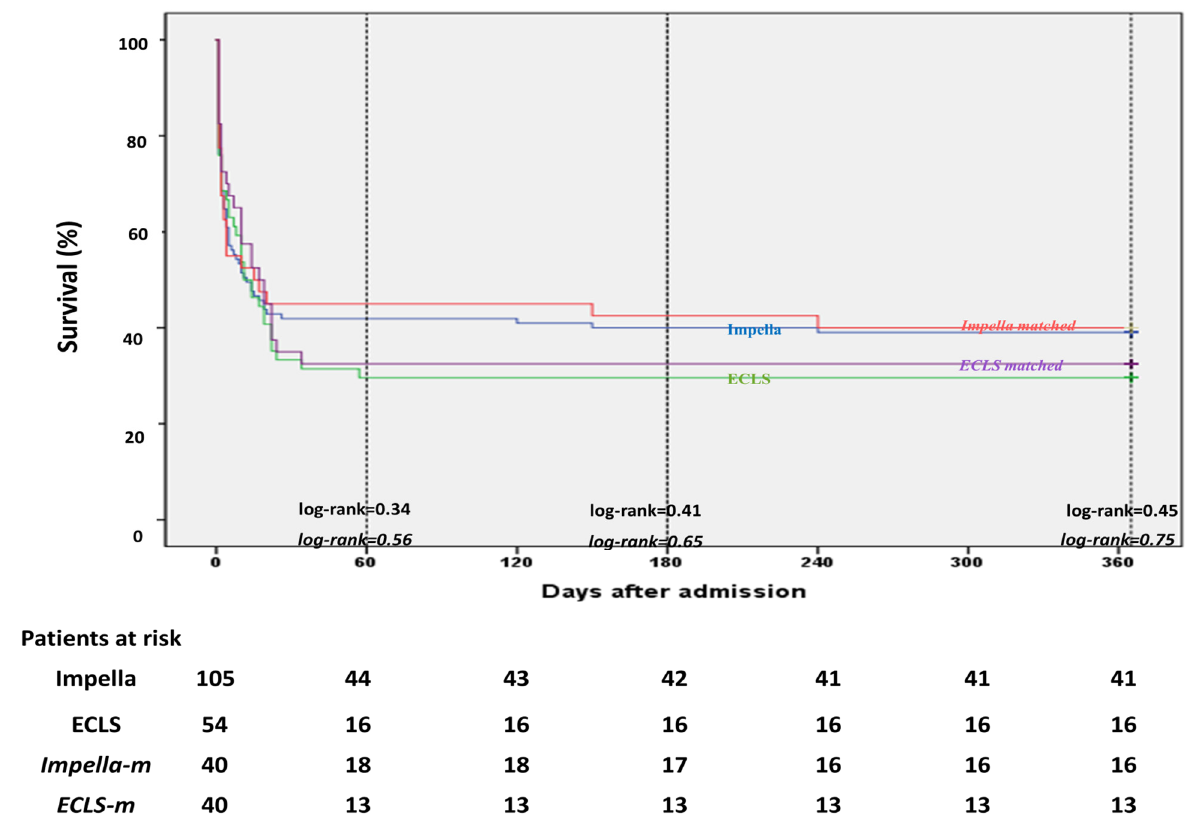
Figure 1. Kaplan–Meier curves demonstrating 12-month survival in Impella and ECLS patients among overall and matched cohort.